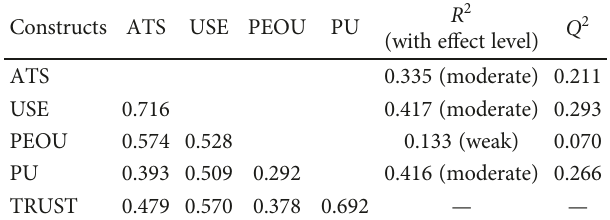
Table 5: HTMT and explanatory and predictive capacity of the model.